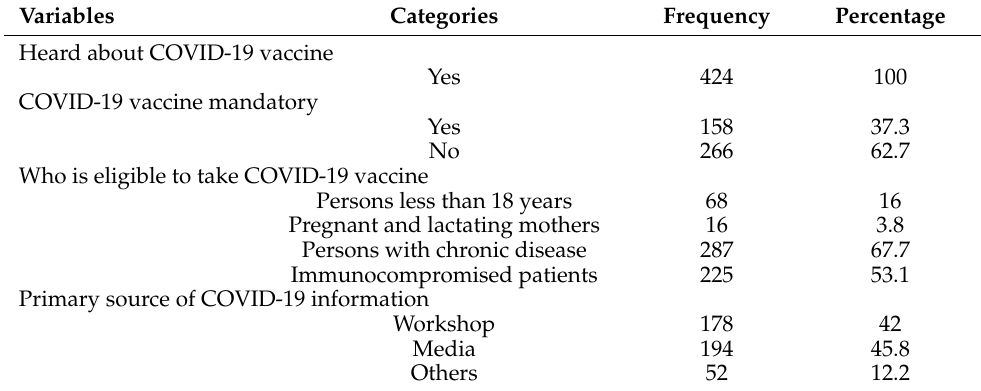
Table 2. Knowledge about COVID-19 vaccine (N = 424).